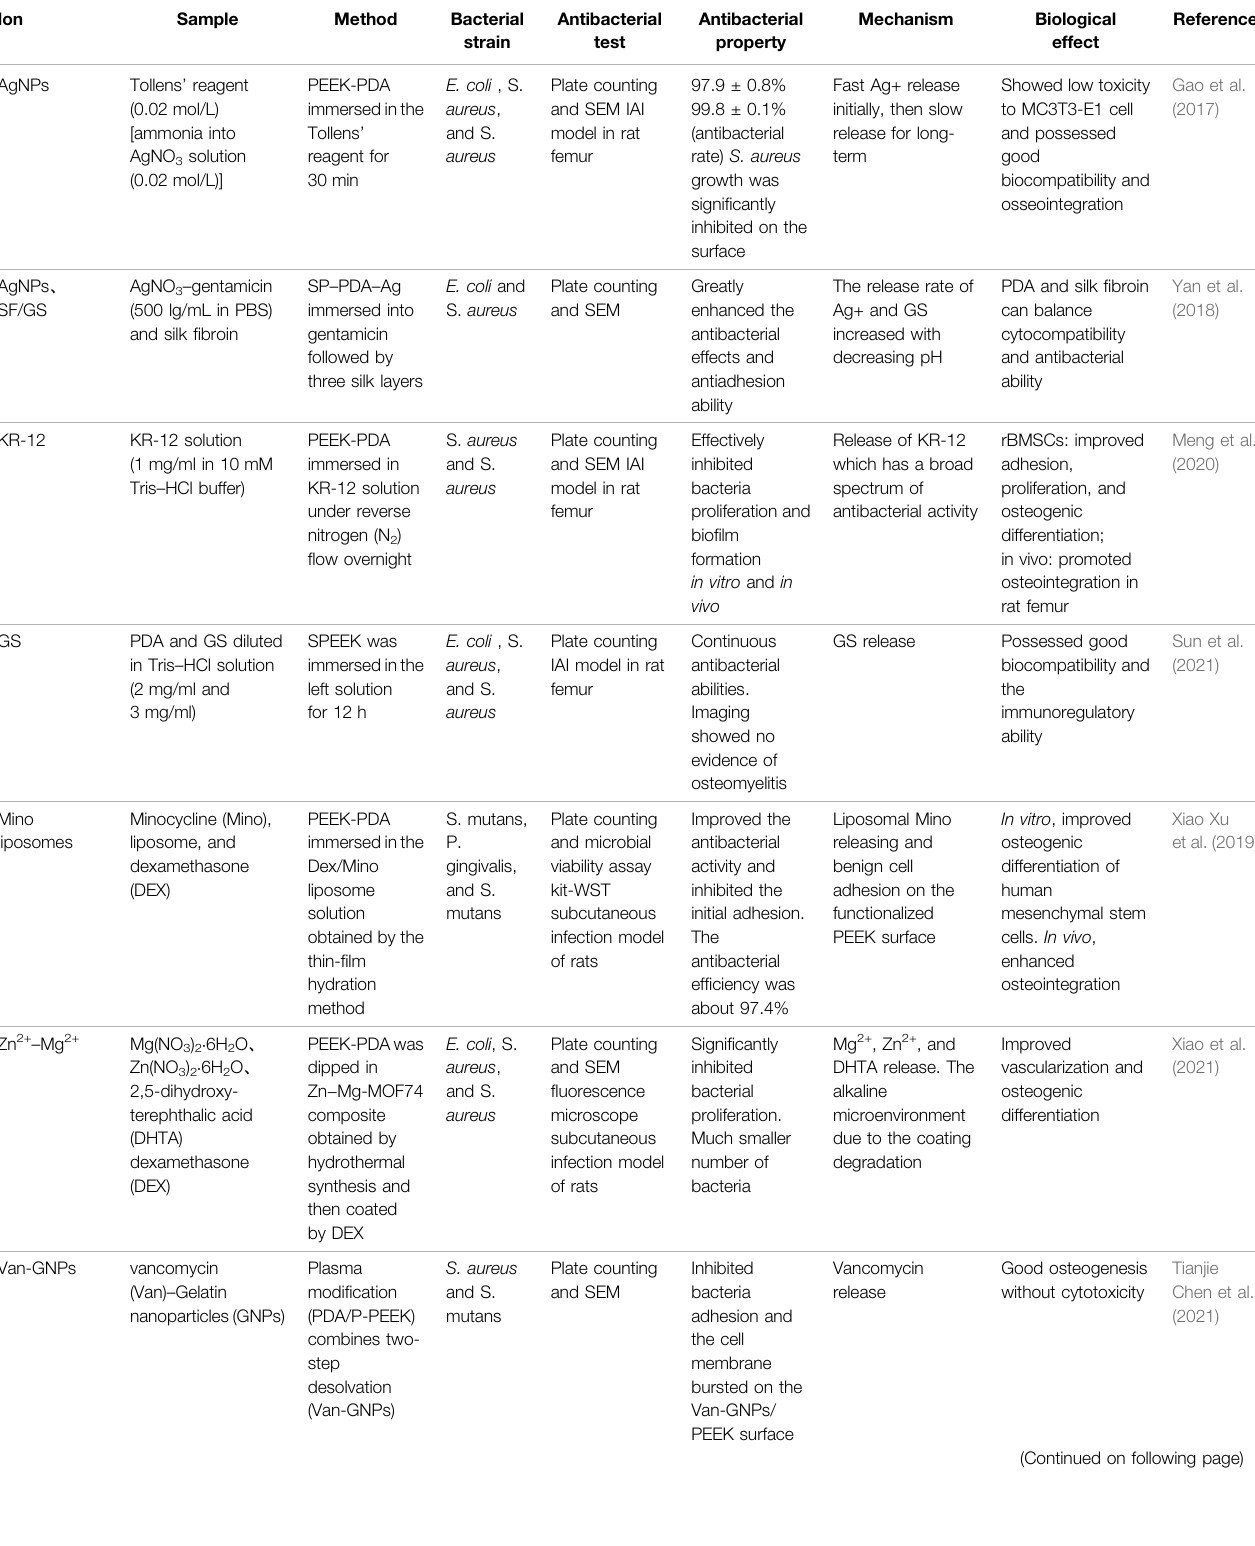
TABLE 2 | Controlled release of antimicrobial agents on the PEEK-PDA (2 mg/ml dopamine hydrochloride)